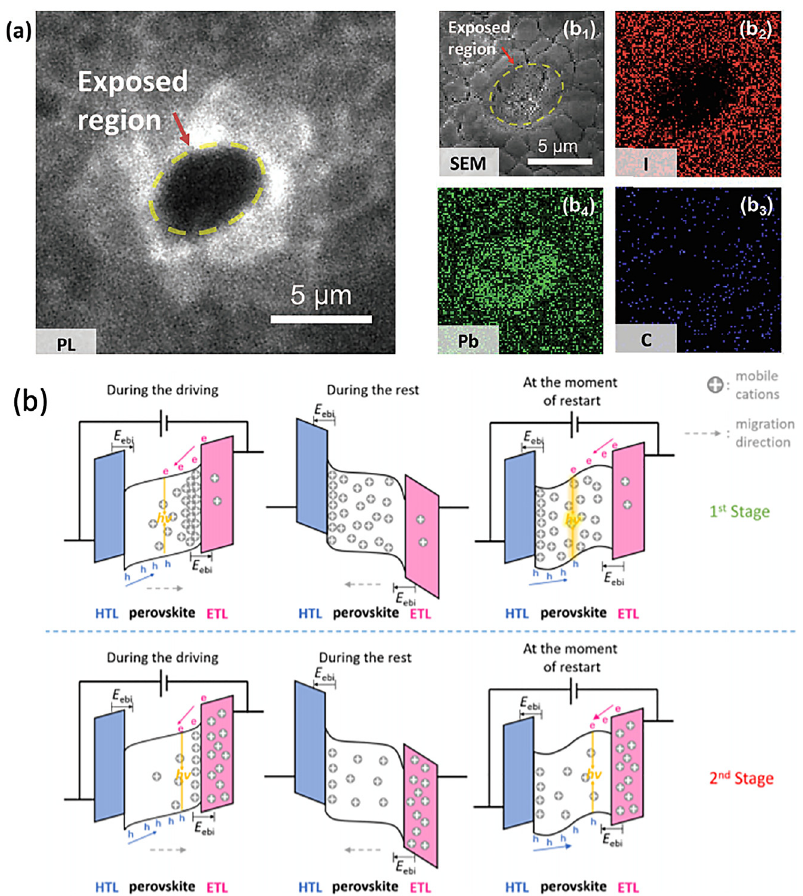
Figure 11: (a) Photoluminescence wide-field image directly after 1 min of focused laser exposureinaMAPbI3thin fi lm.(ii)Scanning electron microscopic (SEM) and energy dispersive X-ray (EDX) images representing elemental distribution of the elements I, C and Pb, recorded from the same fi lm area 1 min after laser exposure. Adapted with permission from [255]. (b) Schematic showing the band energy alignment and movement of mobile cations in the fi rst and second stages of EQE decay. Adapted with permission from [256]. Copyright (2020) American Chemical